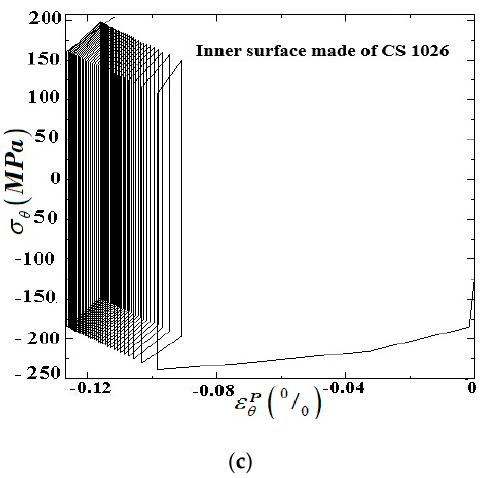
Figure 12. Corresponding stress–plastic strain curves in the circumferential direction of FGM tubes with the inner surfaces made of CS 1026 under sustained internal pressure plus cyclic thermal loading for different types of elastic–plastic behaviors. ( a ) Elastic shakedown under P in = 0.43 P y and T in = 1.75 T y ; ( b ) plastic shakedown under P in = 0.65 P y and T in = 2.35 T y ; ( c ) ratcheting under P in = 0.75 P y and T in = 1.95 T y .